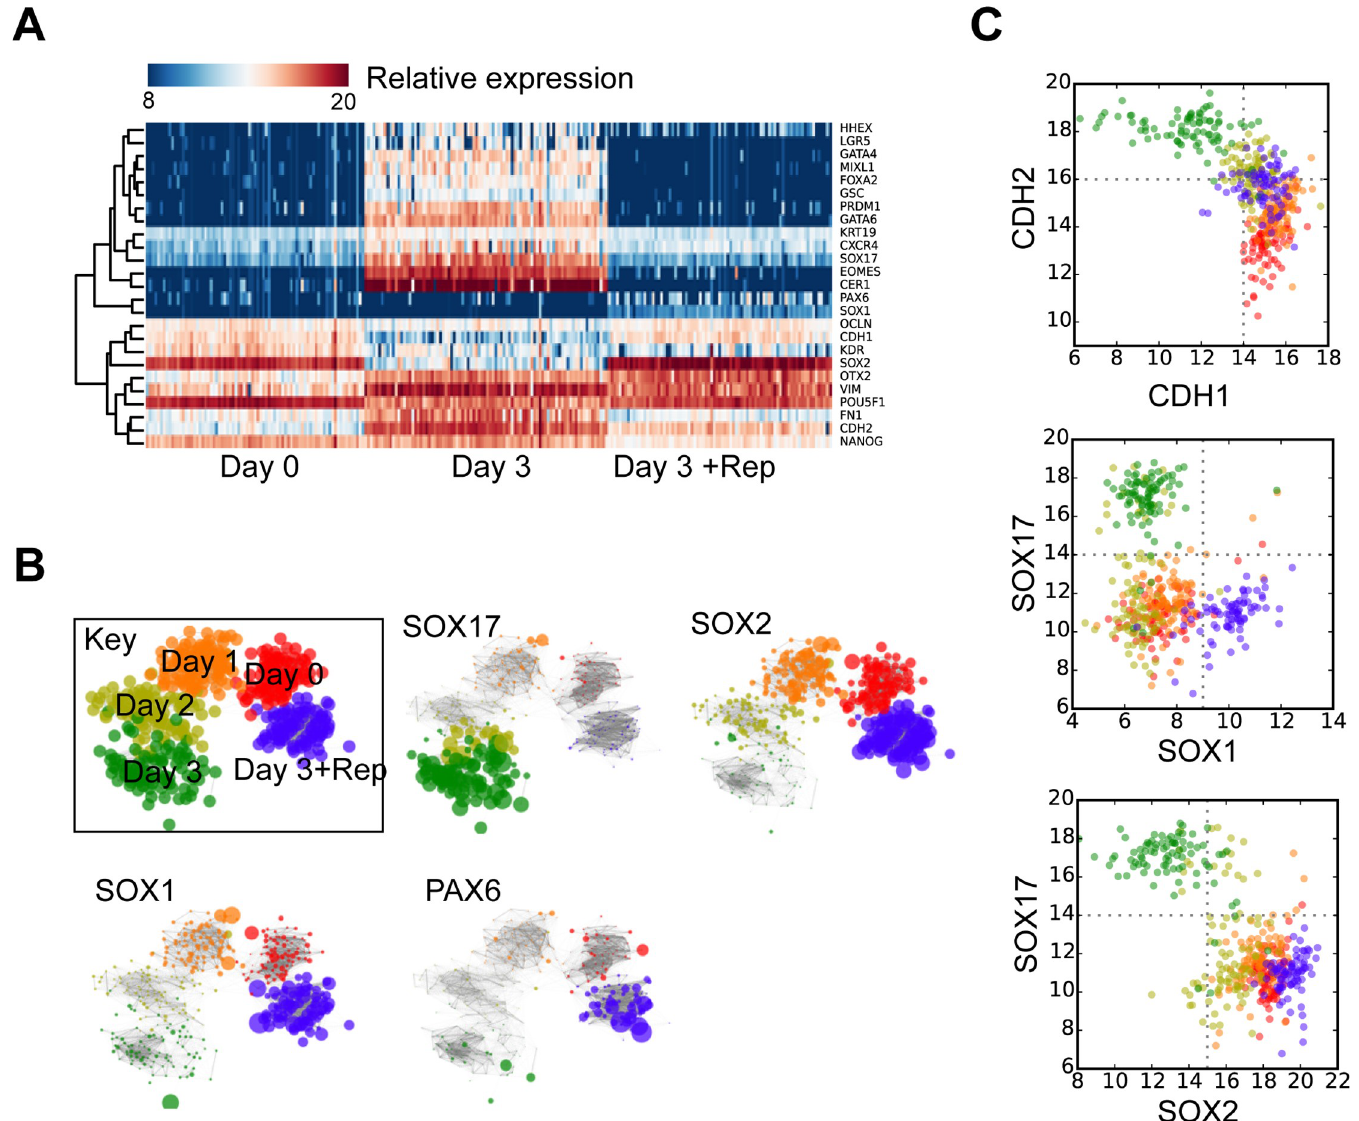
Fig 3. Single cell qPCR on cells treated with activin A and Repsox (Rep) after PS induction, in combination with previously published data. (A) Expression of selected genes. (B) Relation networks of hESCs (day 0), DE differentiation (day 3), and DE induction with Repsox for two days (treatment on day 3). Expression of PAX6 , SOX1 , SOX2 , and SOX17 is indicated, respectively. Each cell is a node and node sizes are 2 [relative expression] . (C) Expression levels of CDH1 versus CDH2 , SOX1 versus SOX17 , and SOX2 versus SOX17 . Colors are the same as used in panel